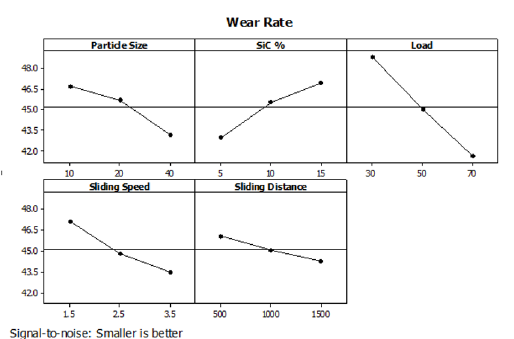
Figure 2. Influence of various parameters on S/N ratio for wear rate (smaller is better)